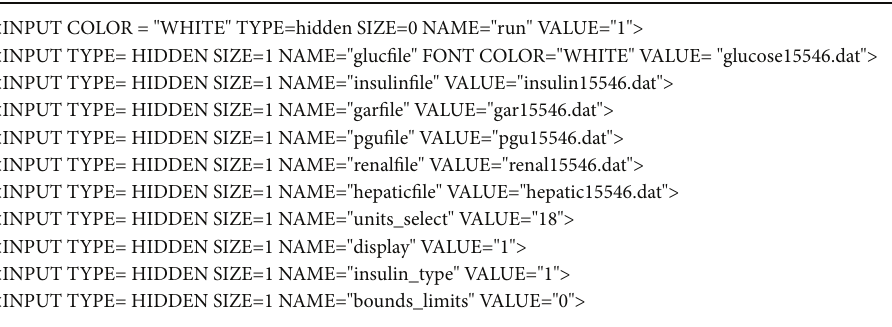
Figure 2: (a) Data from an ASCII (American Standard Code for Information Interchange) text file for an example case scenario (number 0010: Hugh Allibaster) from the AIDA online database. Depending which case scenario the user selects, these data are read in and used as the basis for an initial (baseline) simulation. Forty case scenarios exist in AIDA online, data imported from AIDA v4. Colour key, highlighted in figure. Yellow: weight (in kg). Green: meal times and grams of carbohydrate. Cyan: preparations, times, and dosages of insulin injections. Magenta: renal threshold of glucose, creatinine clearance rate, and hepatic and peripheral insulin sensitivity parameters, respectively. (b) Hidden fields in the dynamically generated HTML web pages produced by the AIDA online cgi-bin Perl scripts. These fields are used to store parameters and case details to be transferred between simulation runs. “units select” value = 18 for mg/dL blood glucose units; value = 1 for mmol/L. Premixed/biphasic “insulin type” value = 2. “display” value = 1 is standard display; “display” value = 2 is advanced/fluxes display. “run” value = 1 is the simulation run number (1 = first, baseline simulation). “run” value number increments for each subsequent simulation. “bounds limits” value = 1 would show the user-defined normoglycaemic ranges. 5 digit number is a PID = process identification number generated by the web server for each separate